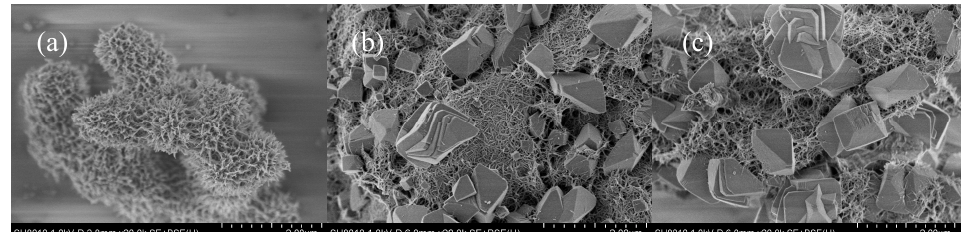
Figure 7. Scanning electron microscopy (SEM) images of the iron hydroxysulfate minerals mediated by A. ferrooxidans under different O 2 supply times, i.e., ( a ) limited O 2 supply at 0 h; ( b ) limited O 2 supply at 36 h and ( c ) unlimited O 2 supply.